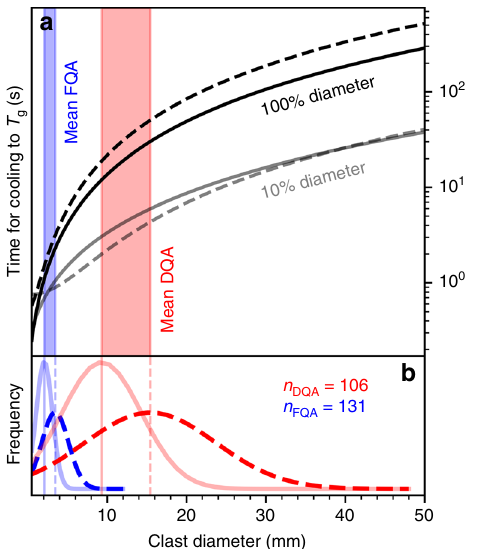
Fig. 5 The cooling rates of pumiceous achneliths during fl ight by clast diameter. a The results of the thermal modelling with the black and grey lines representing the time taken for 100% and 10% of the diameters, respectively to cool below T g . The dashed lines show the results assuming a vesicularity of 0.9, whilst the solid lines represent a vesicularity of 0, thus bracketing the true vesicularity for any given pyroclast. b Best- fi t gaussian size distributions of FQAs (blue) and DQAs (red). The dashed lines indicate the diameters of the achneliths as measured (i.e., vesicular), and the solid lines indicate the recalculated diameters once the vesicularity (assumed to be 0.9) has been removed. In both panels, the mean diameters of the original FQAs and DQAs (i.e., zero vesicularity) and the fi nal in fl ated FQAs and DQAs (i.e., porosity = 0.9) are shown by vertical lines and provide the range of diameters over which the mean FQA and DQA evolved from